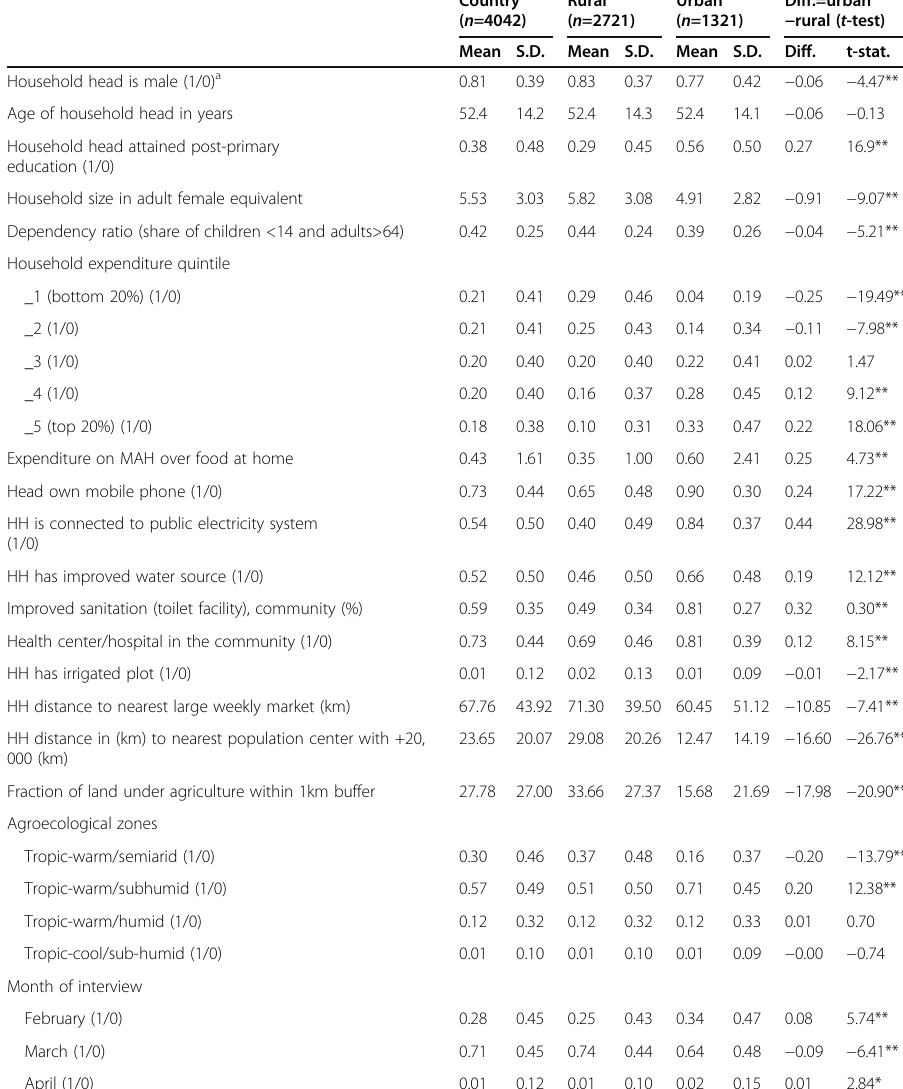
Table 1 Descriptive statistics of key variables used in the regressions ( N =4042)